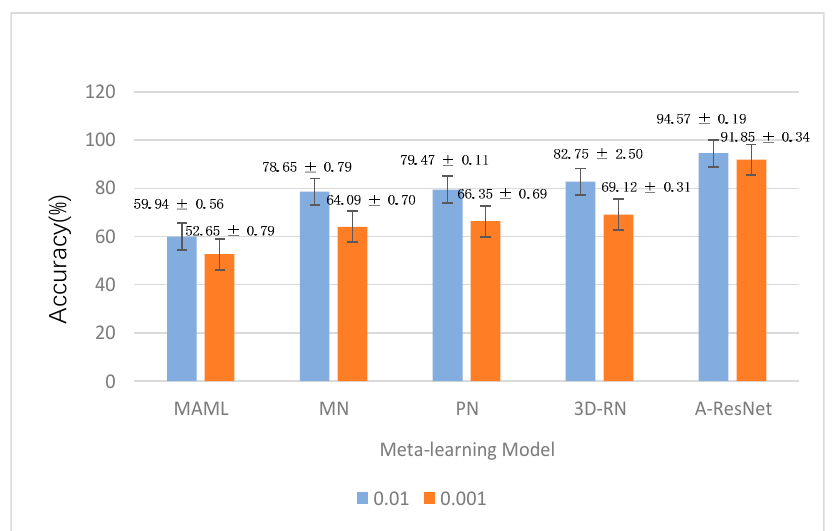
Figure 12. The accuracy of the A-ResNet model and other models under the 5-shot case.